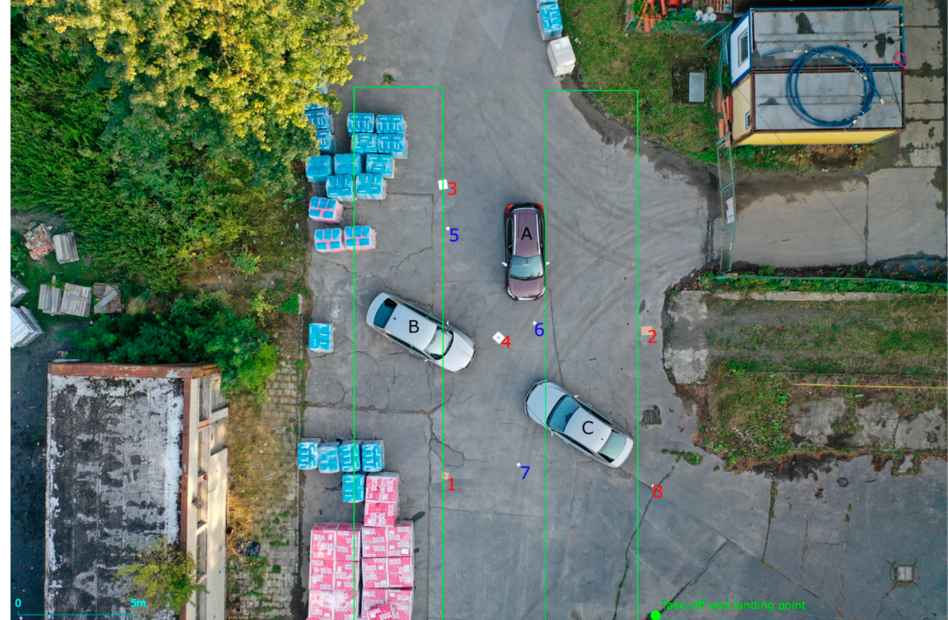
Figure 2. Overview of arranged traffic accident site with reference objects. A, B, C—vehicles; 1, 2, 3, 4, 8—reference objects with known dimensions; and 5, 6, 7—reference points for measurements. Green line represents third flight’s trajectory.